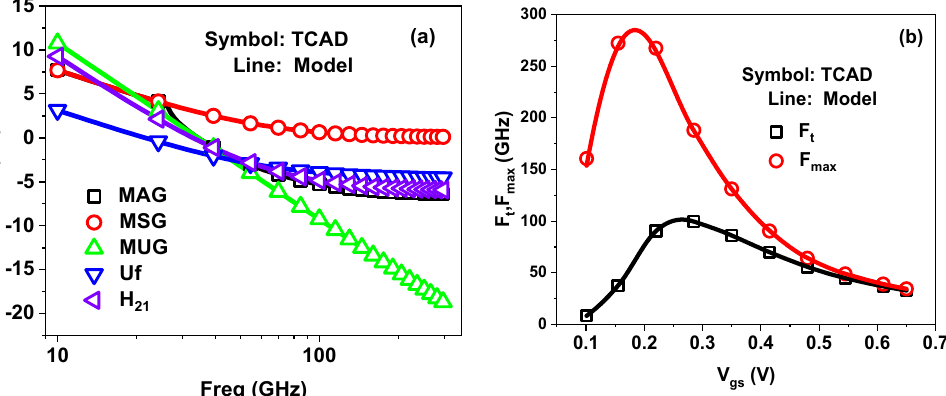
Figure 9. Comparison between TCAD-simulated and -modeled S-parameters under V gs = 0.65 V, V ds = 0.05 V and V gs = 0.65 V, V ds = 0.65 V. ( a ) S12, ( b ) S11, ( c ) S21 and ( d ) S22.